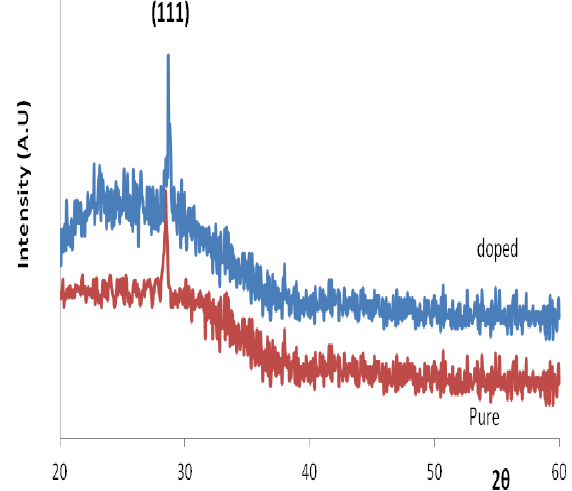
Fig. 1: X-ray diffraction for pure ZnS and ZnS:Pb